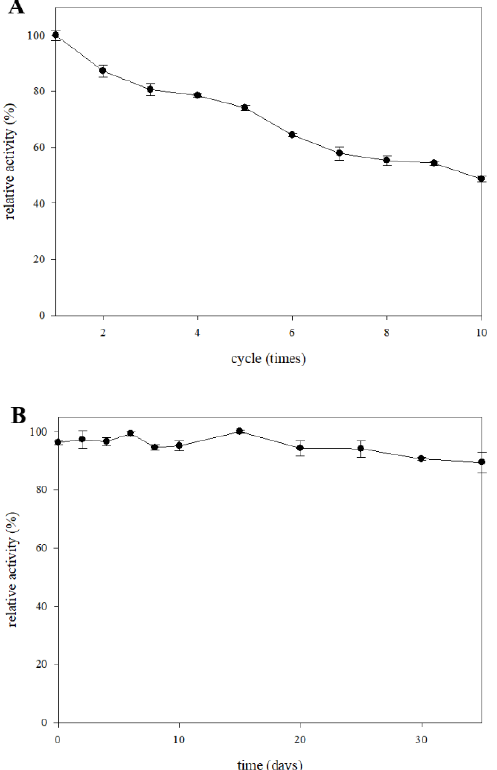
Figure 4. The usability ( A ) and the storage stability ( B ) of immobilized β‐ glucosidase. Each value is expressed as mean ± SD.